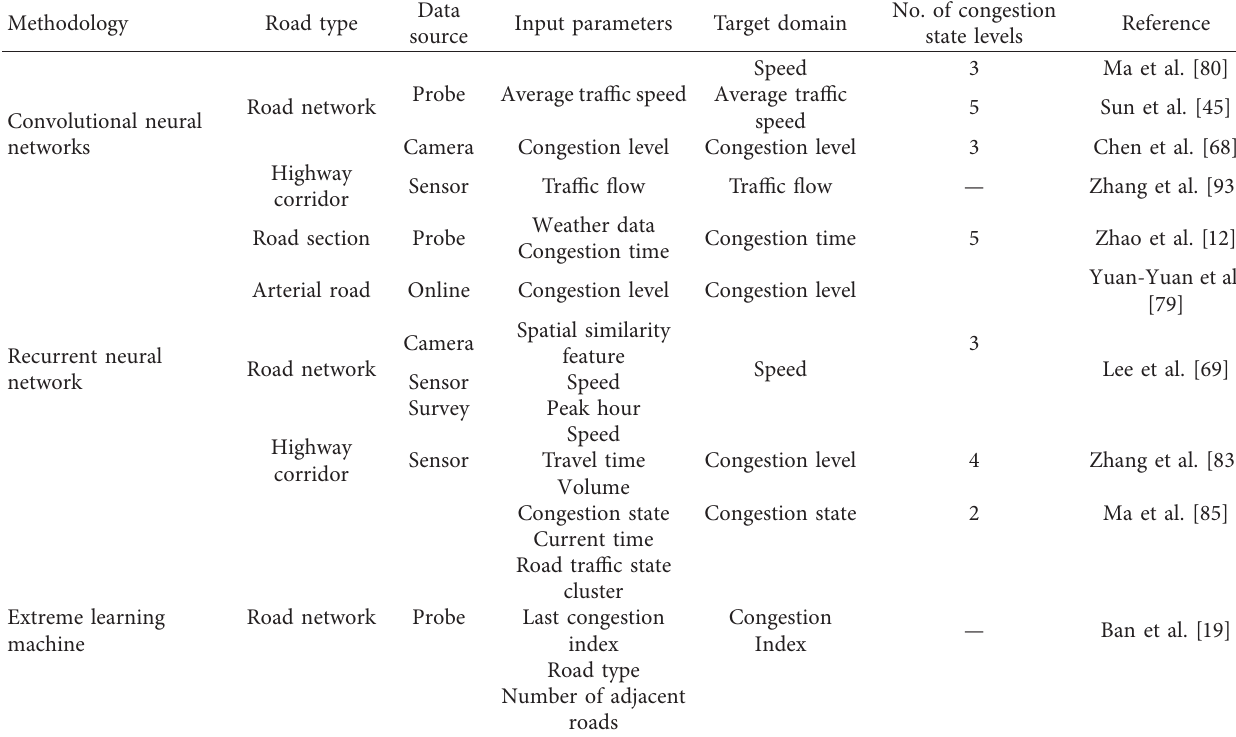
Table 3: Traffic congestion prediction studies in deep machine